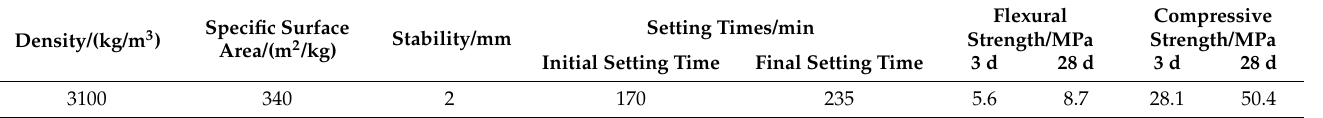
Table 2. Physical properties of PO 42.5 cement.